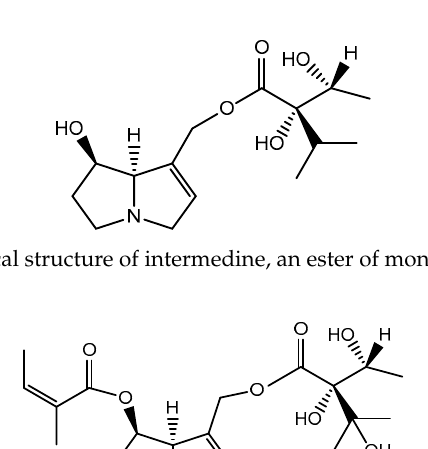
Figure 3. Chemical structures of necic acids.